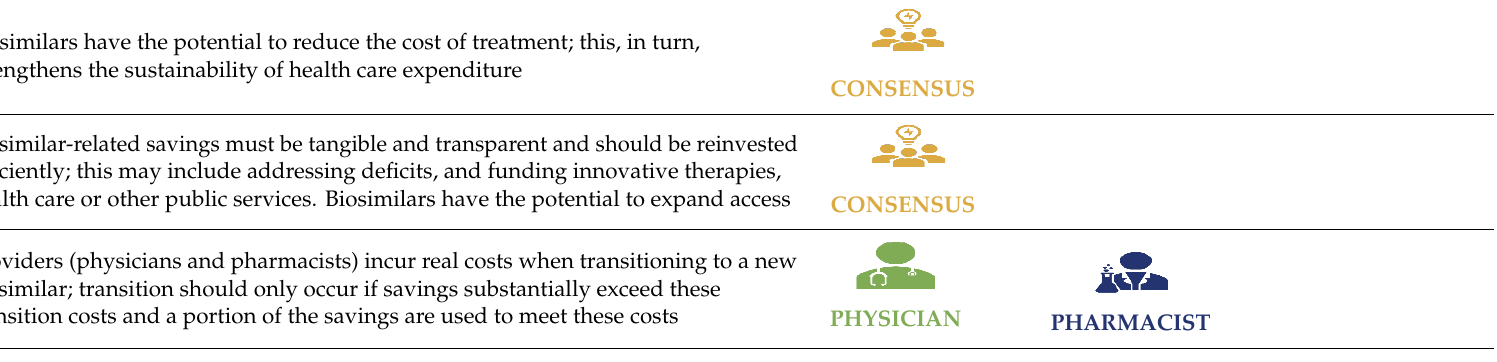
Table 1. Consensus on components of a sustainable biosimilar